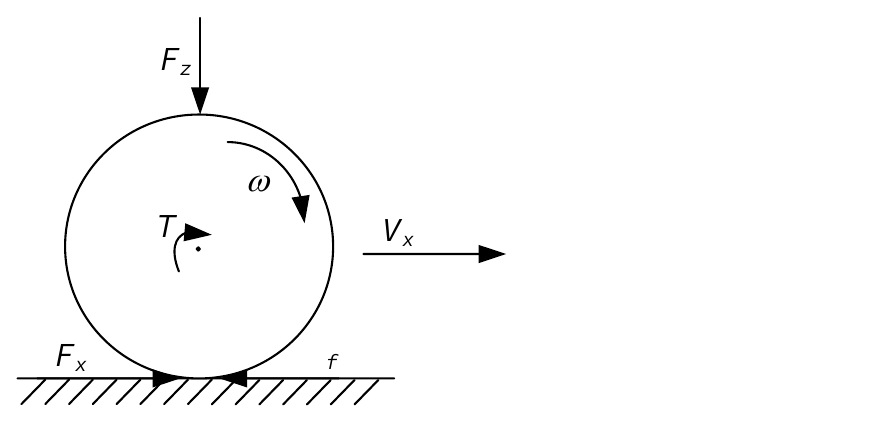
Figure 3. Single-wheel longitudinal dynamics model.